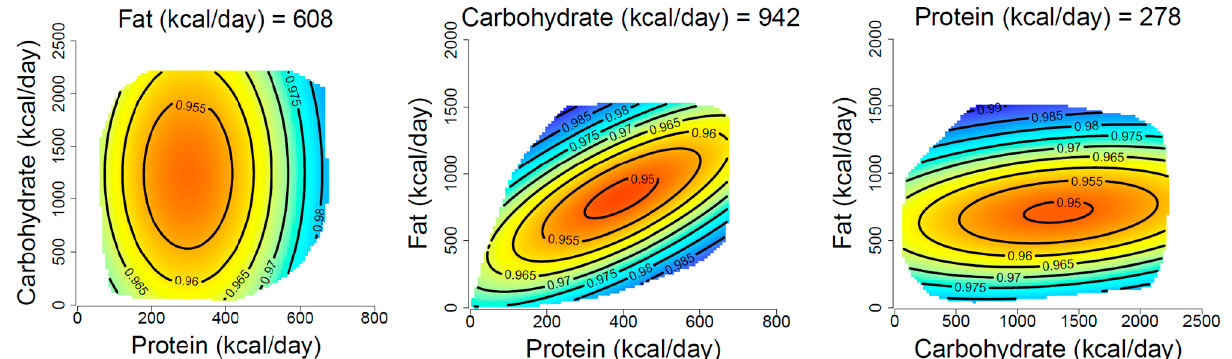
Figure 1. Macronutrient absolute intake and all-cause mortality. Each surface shows the survival function scale for all-cause mortality in a nutrient space of all three macronutrients. The x and y -axes represent two macronutrient exposures sliced through the median value of the macronutrient shown at the top of each figure. Response values are colored such that warm colors show a higher risk of mortality and cooler colors show a lower mortality risk. Response surfaces were adjusted for age, sex, household income, BMI, physical activity, and Healthy Eating Index.